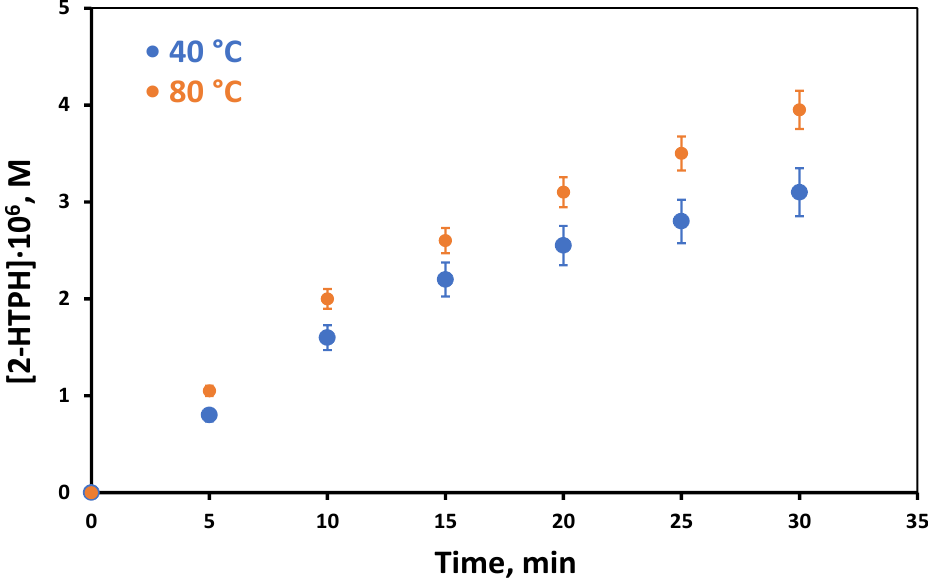
Figure 4. Kinetics of photocatalytic • OH radical formation as a function of bulk temperature measured using terephthalate dosimetry in the presence of Ti@TiO 2 NPs and in the absence of butanol isomers (Xe lamp, Ar flow).